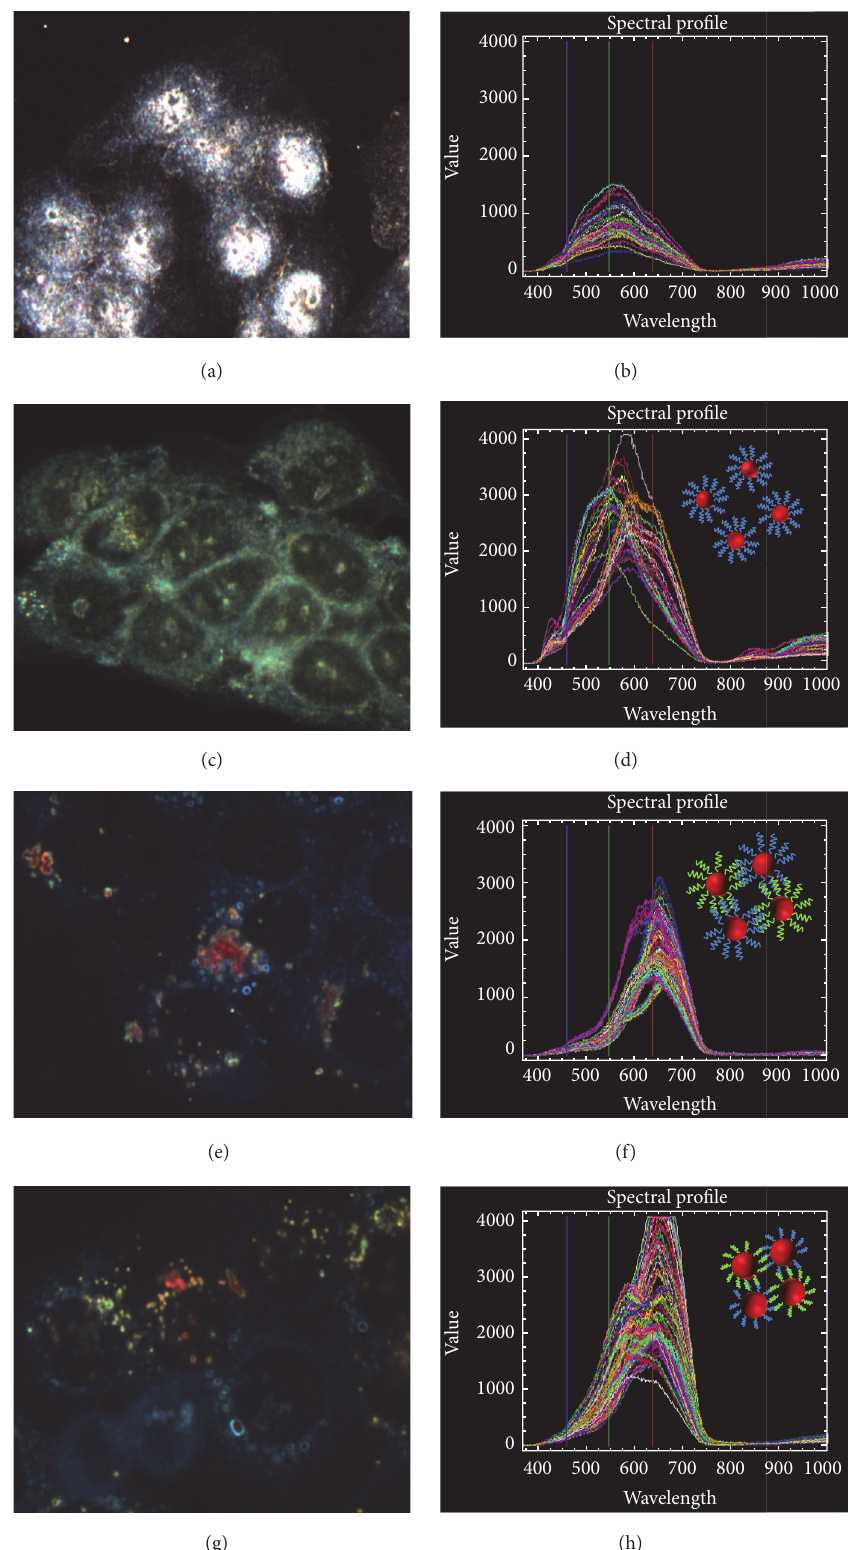
Figure 5: Hyperspectral imaging of untreated HaCaT cells and HaCaT cells treated with hybridized 13nm Au NPs. (a) Digital image and (b) background spectra of untreated HaCaT cells. (c) Digital image and (d) spectra of HaCaT cells treated with 13nm Au A1-pA NPs. (e) Digital image and (f) spectra of HaCaT cells treated with 13nm Au A1 + C1 NPs. (g) Digital image and (h) spectra of HaCaT cells treated with 13nm Au A1-pA + C1-pA